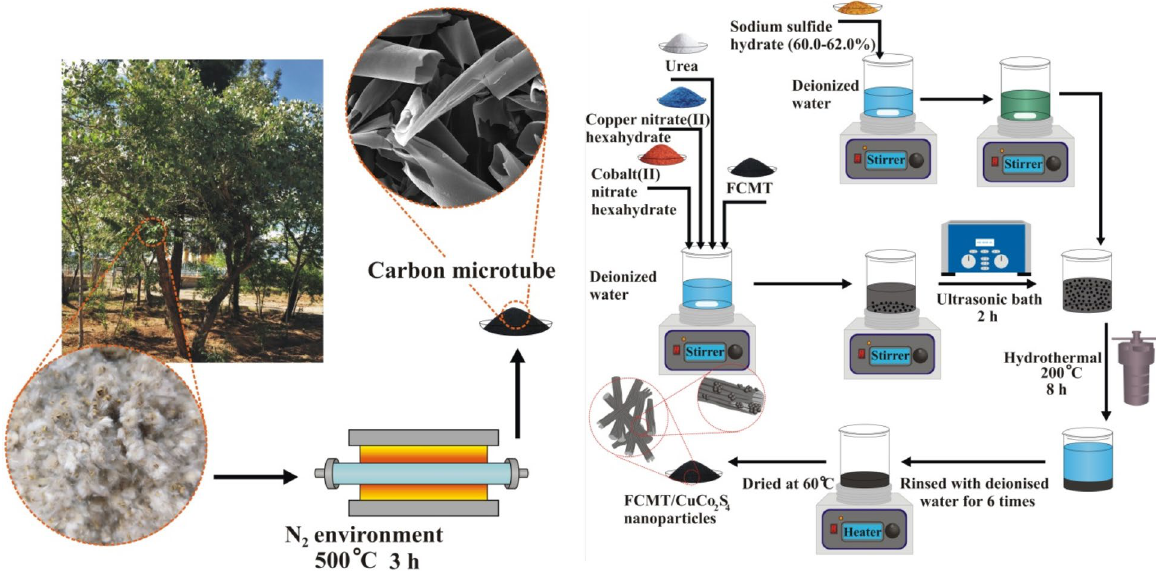
Figure 1. Synthetic route of FCMT/CuCo 2 S 4